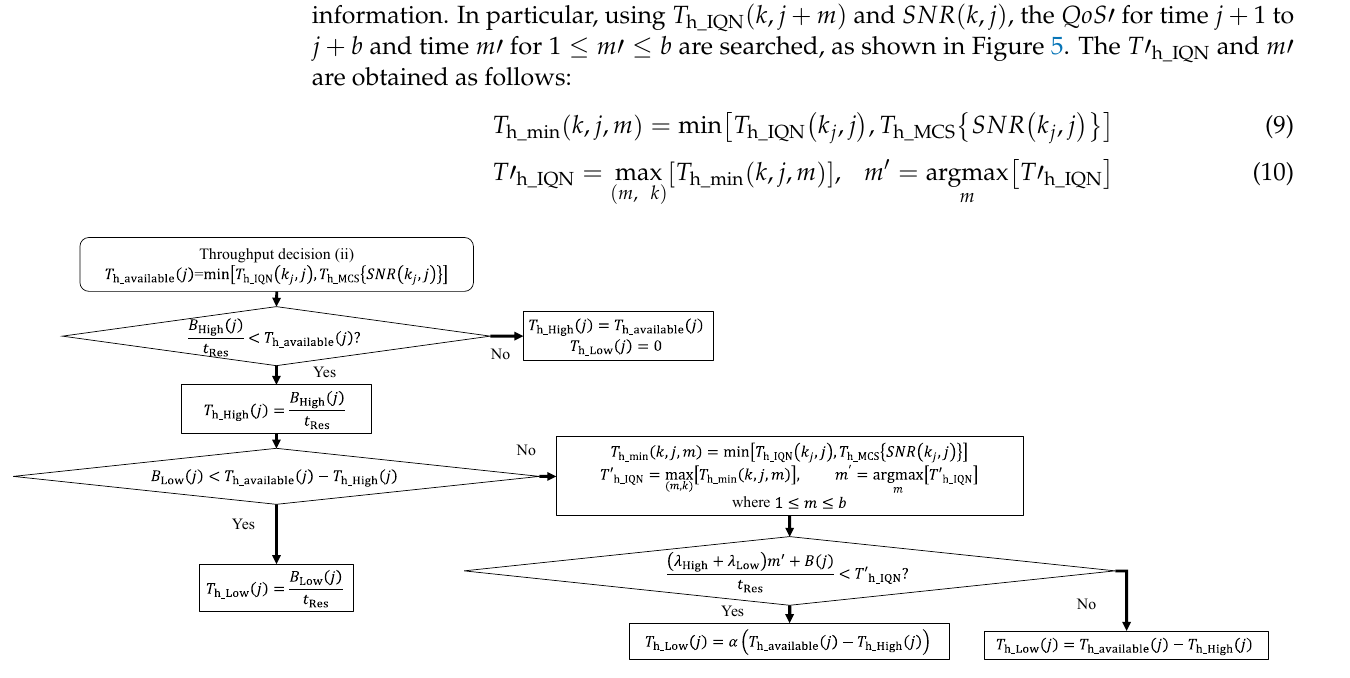
Figure 6. Conventional throughput decision flowchart at vehicle.